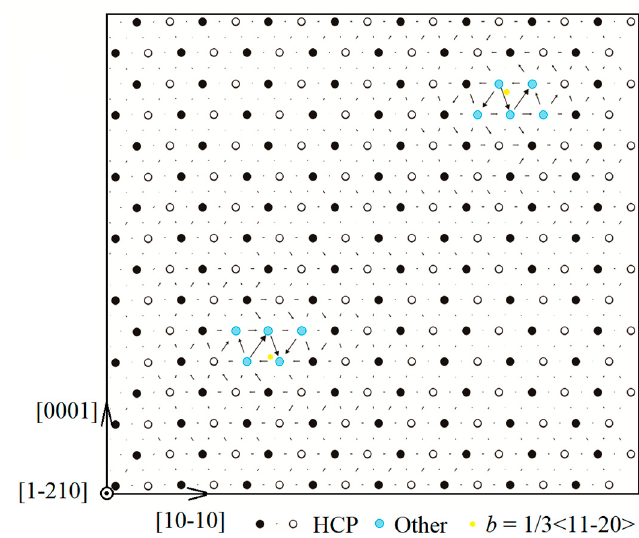
Figure 1. Initial computational supercell with a basal <a> type screw dislocation dipole. The filled and empty circles are colored according to the sequence of <11-20> atomic planes. The magnitude of the arrows in the DD-plots represents the differential displacement of the neighboring rows along [1-210] direction. The center of the dislocation core locates at the closed circuit of arrows or can be represented by the dislocation line (yellow dots), which are perpendicular to the paper. Black/white (filled/empty) and blue sites correspond to hexagonal close-packed (HCP) and other structures, which indicate the perfect lattice and core region in the lattice, respectively. The same convention holds in Figures 2 and 3.